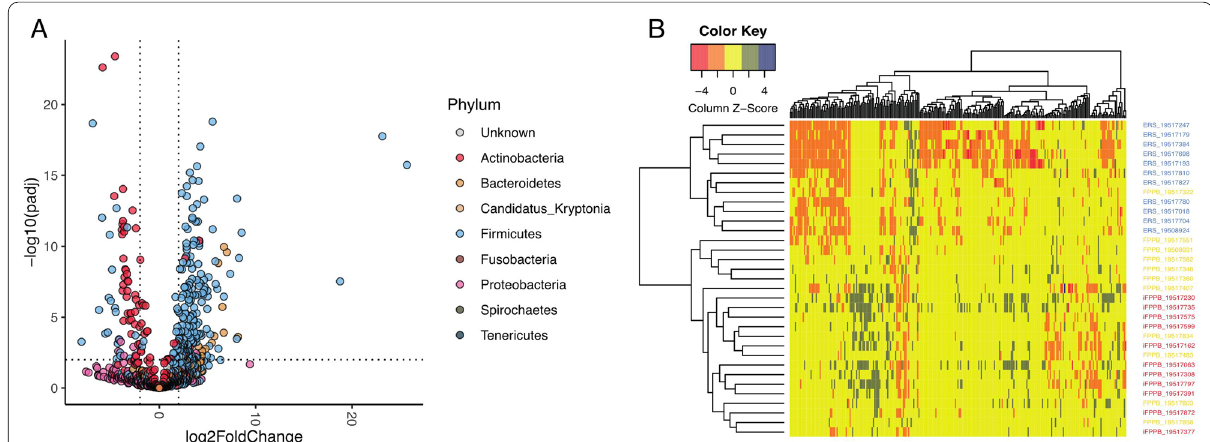
Fig. 3 Bacterial species differences of fecal samples collected from cats fed the experimental diets. A A volcano plot showing differential abundance of 259 bacterial species between diets. Each dot is a bacterial species and dots are colored by phylum. Positive values in x-axis represent species that increased in abundance in the FPPB and/or iFPPB diets relative to ERS and negative values in the x-axis represent species that decreased in abundance in these diets relative to the ERS diet. The horizontal dotted line represents significance threshold of FDR adjusted P -value < 0.01 obtained from DESeq2 and the two horizontal lines differentiate the species with log2 fold change in abundance. Species with FDR adjusted P values < 0.01 and absolute log2 fold change > 2 were considered statistically significant. B Heatmap showing differences in relative abundance of differentially abundant bacterial species between the diet